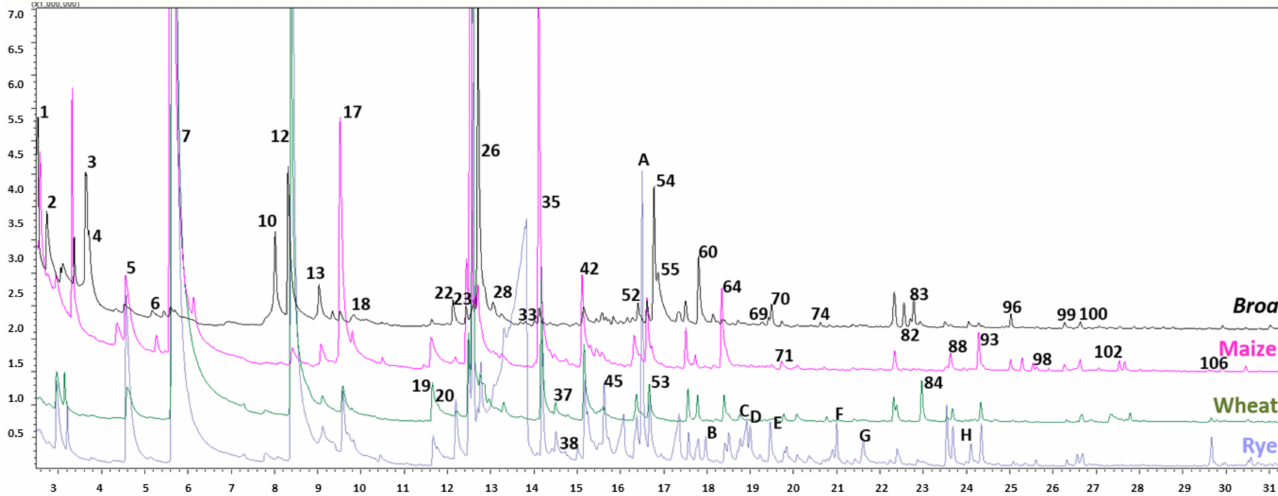
Figure 1. Chromatographic profiles of broa and maize, wheat and rye flours. Peaks are numbered according to Table 2 and letters represent compounds detected exclusively in rye and/or wheat flours, namely, A: α -terpinolene, B: camphor, C: octanoic acid, D: 4-terpineol, E: α -terpineol, F: linalyl acetate, G: nonanoic acid, H: